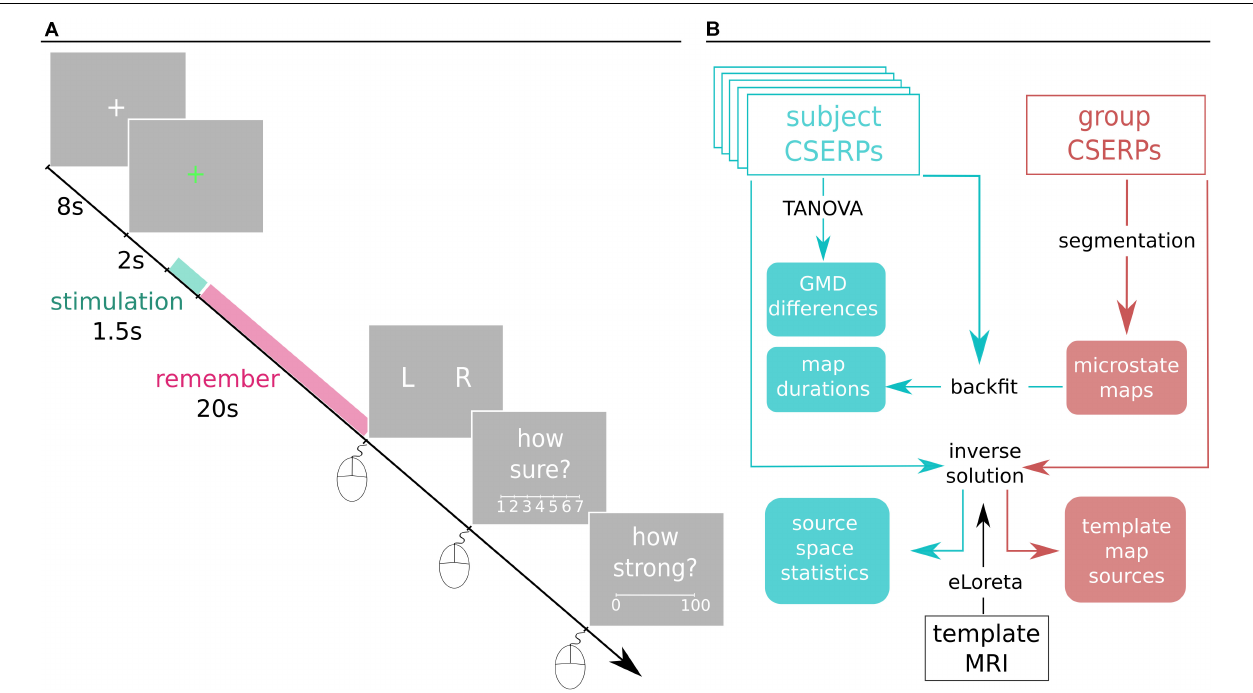
FIGURE 1 | (A) Depiction of a trial. Each trial starts off with a white fixation cross that turns green after 8 s. After 2 s, the 1.5 s stimulation starts, and participants are instructed to detect and remember the stimulated nostril. After 20 s, participants are asked to indicate the stimulated side, rate the confidence of the nostril identification, and indicate the strength of the perceived stimulation by means of mouse clicks with the right hand. For respective scale descriptions, see main text in section “Procedure” (B) Spatiotemporal processing pipeline. Cyan represents subject-based CSERP data and derived results on a classical group level. Red is associated with the two grand condition averages. Black texts are processing tools, and filled boxes are results. CSEPRs: chemosensory event-related potentials, TANOVA: topographic analysis of variance, GMD: global map dissimilarity, eLORETA: exact low resolution electromagnetic tomography, MRI: magnetic resonance